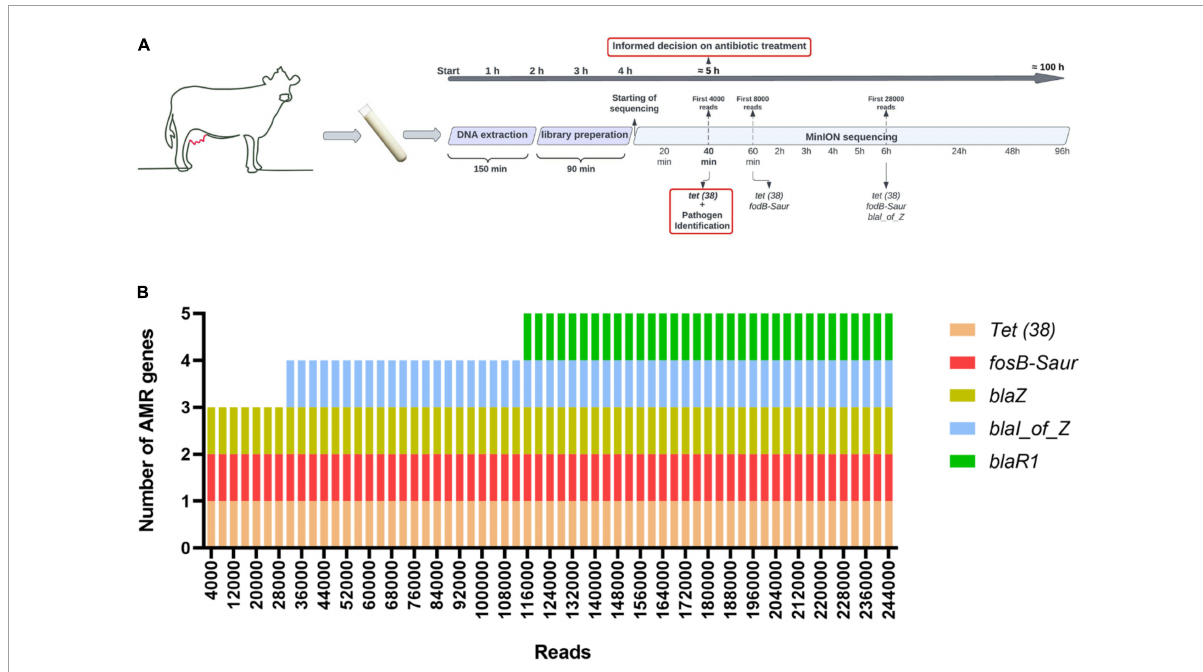
FIGURE6 Study workflow and comparison of the amount of data needed for AMR detection following two different base calling modes. Data was obtained following DNA sequencing for the Mol Com5 cent − nuc approach (one of the replicates). (A) Timing of experiment and time/reads required for AMR gene detection following FAST base calling and using real-time data analyses. (B) Number of AMR genes detected per amount of data, following high accuracy base calling for the same